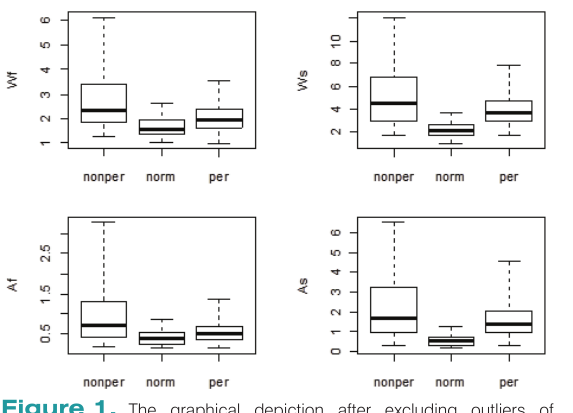
Figure 1. The graphical depiction after excluding outliers of parameters (Wf, Ws, Af, As) of the patient